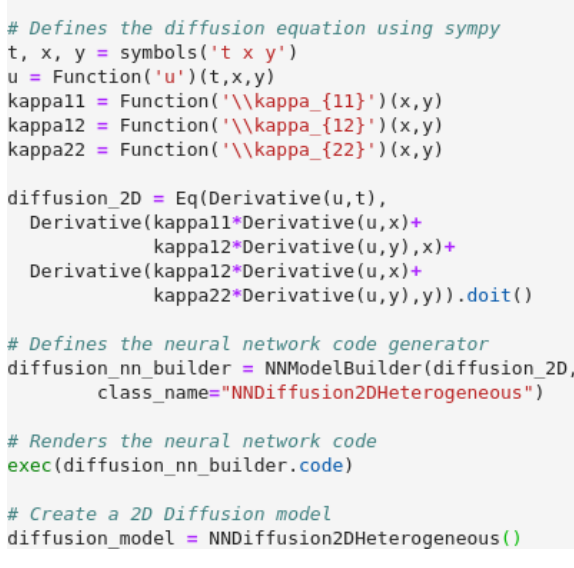
Figure 1. Neural network generator for a heterogeneous 2D diffu- sion